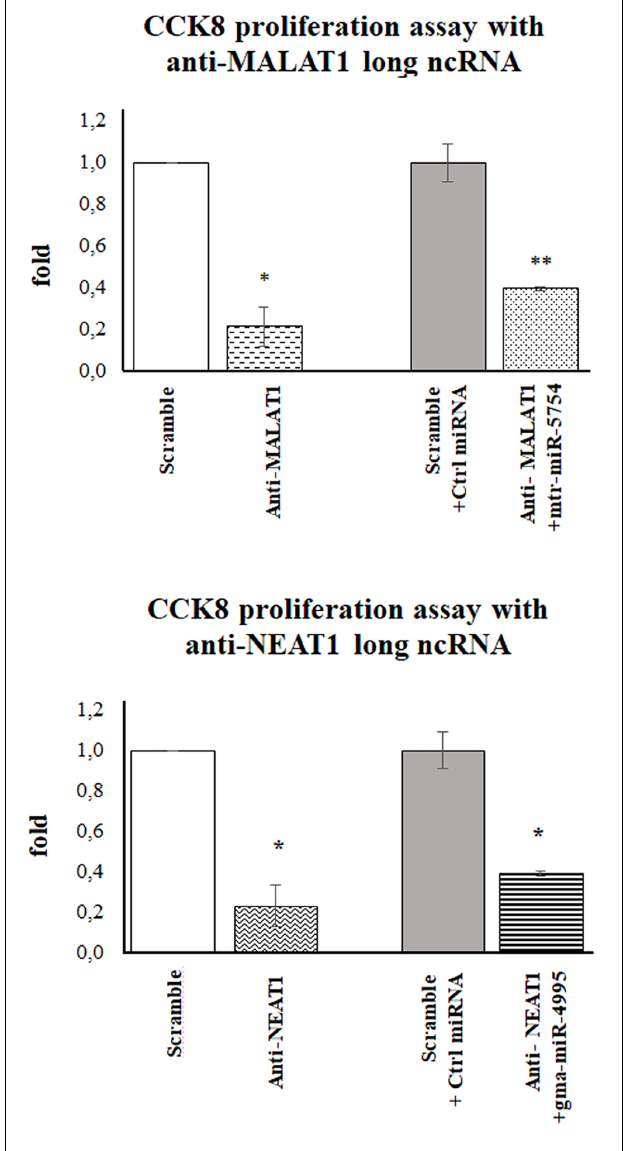
FIGURE 7 | Plant mtr-miR-5754 or gma-miR-4995 reduced cell proliferation through metastasis-associated lung adenocarcinoma transcript 1 (MALAT1) and nuclear paraspeckle assembly transcript 1 (NEAT1) downregulation. Cell Counting Kit-8 (CCK-8) assay of HCT116p53 − / − cells transfected with scramble small interfering RNA (siRNA), MALAT1- or NEAT1-specific siRNA, and after 24 h with plant mtr-miR5754 or gma-miR4995 (* p < 0.05 and ** p <